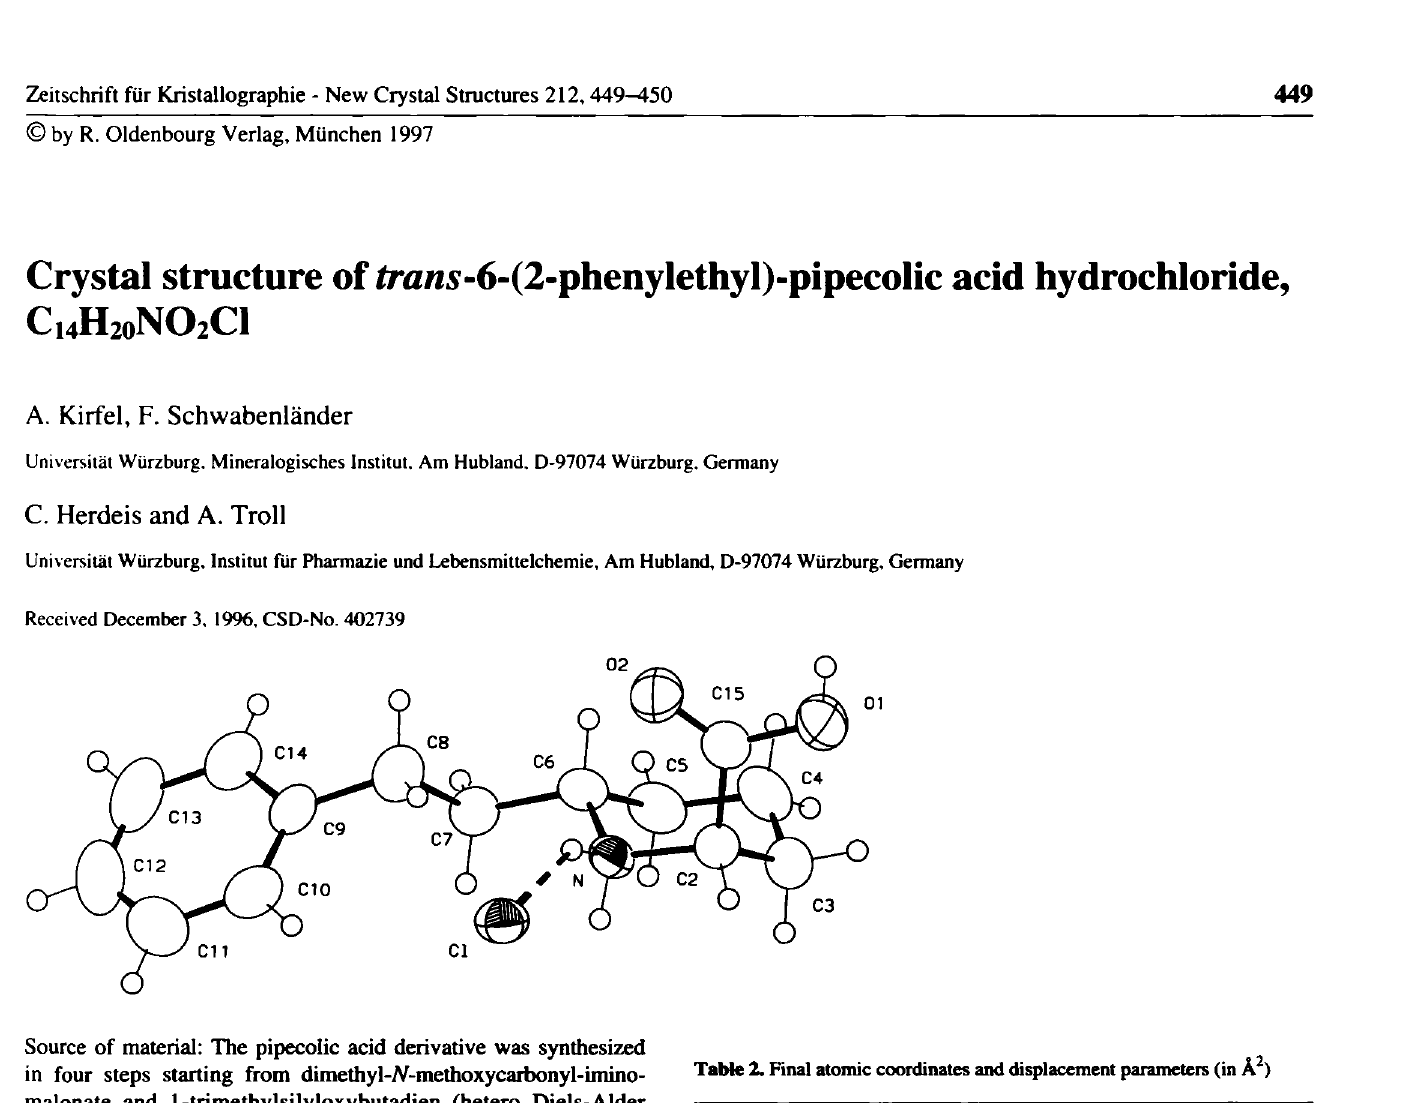
Table 1. Parameters used for the X-ray data collection